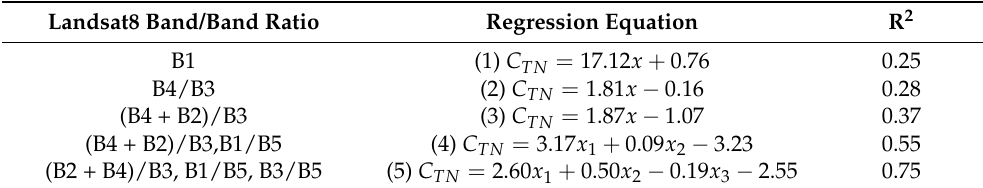
Table 2. Statistical method retrieval functions of TN. The numbering order of x corresponds to the band